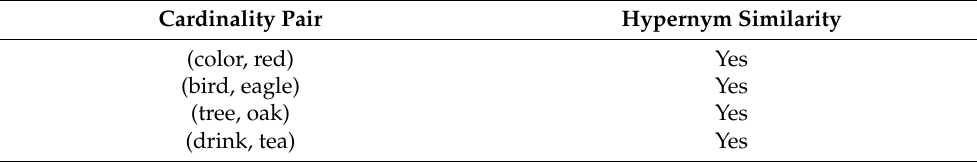
Table 10. Result of hypernym similarity of data properties between classes B, and